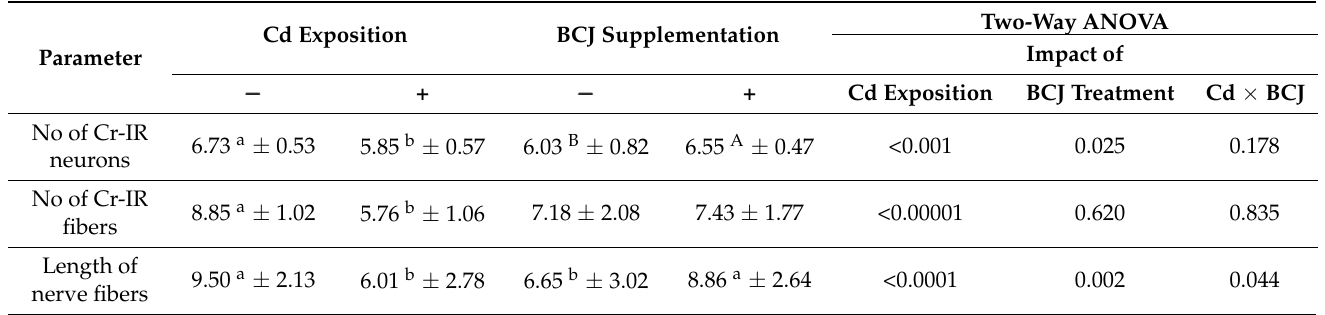
Table 1. The impact of experimental factors: Cd exposition and BCJ treatment on average numbers of Cr-IR neurons and Cr-IR nerve fibers and length of nerve fibers ( µ m) in the CA1 field of rat hippocampus in the experimental